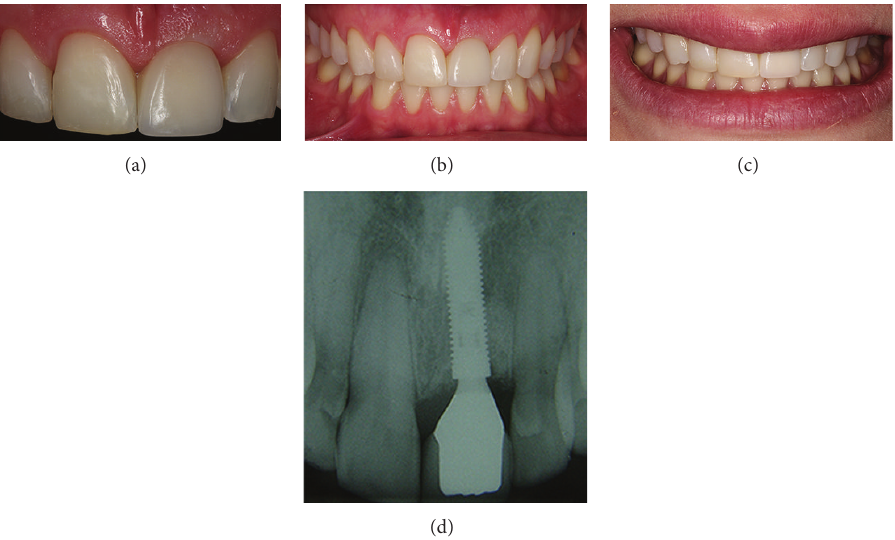
Figure 12: (a, b, c, d) Postoperative clinical and radiographic views, immediately after the conclusion of the prosthetically restored maxillary right central